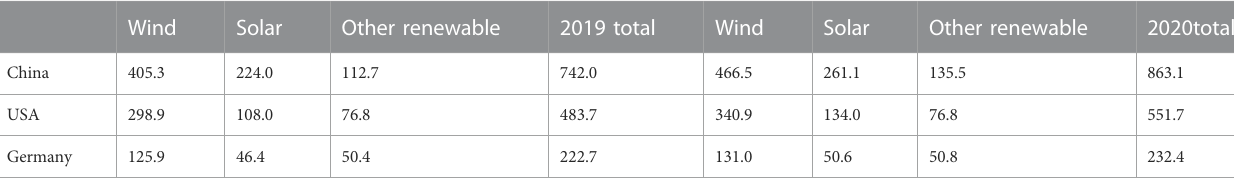
TABLE 1 Renewable energy production by source in the study countries in terawatt-hours. Wind Solar Other renewable 2019 total Wind Solar Other renewable